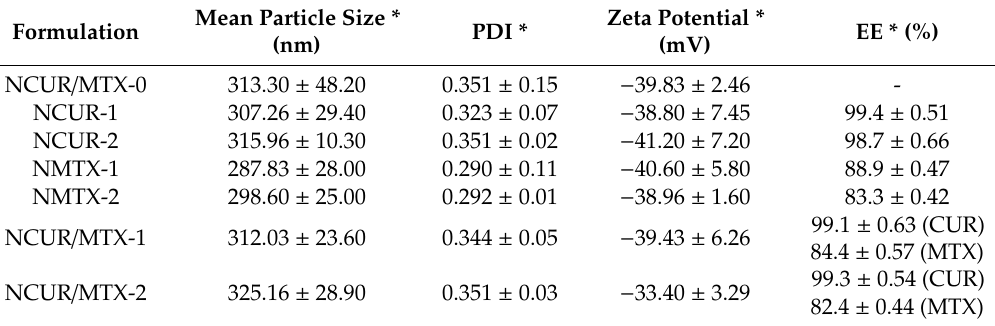
Table 1. Mean diameter, polydispersity index (PDI), zeta potential, and encapsulation e ffi ciency (EE) of the obtained CUR and / or MTX-loaded and non-loaded